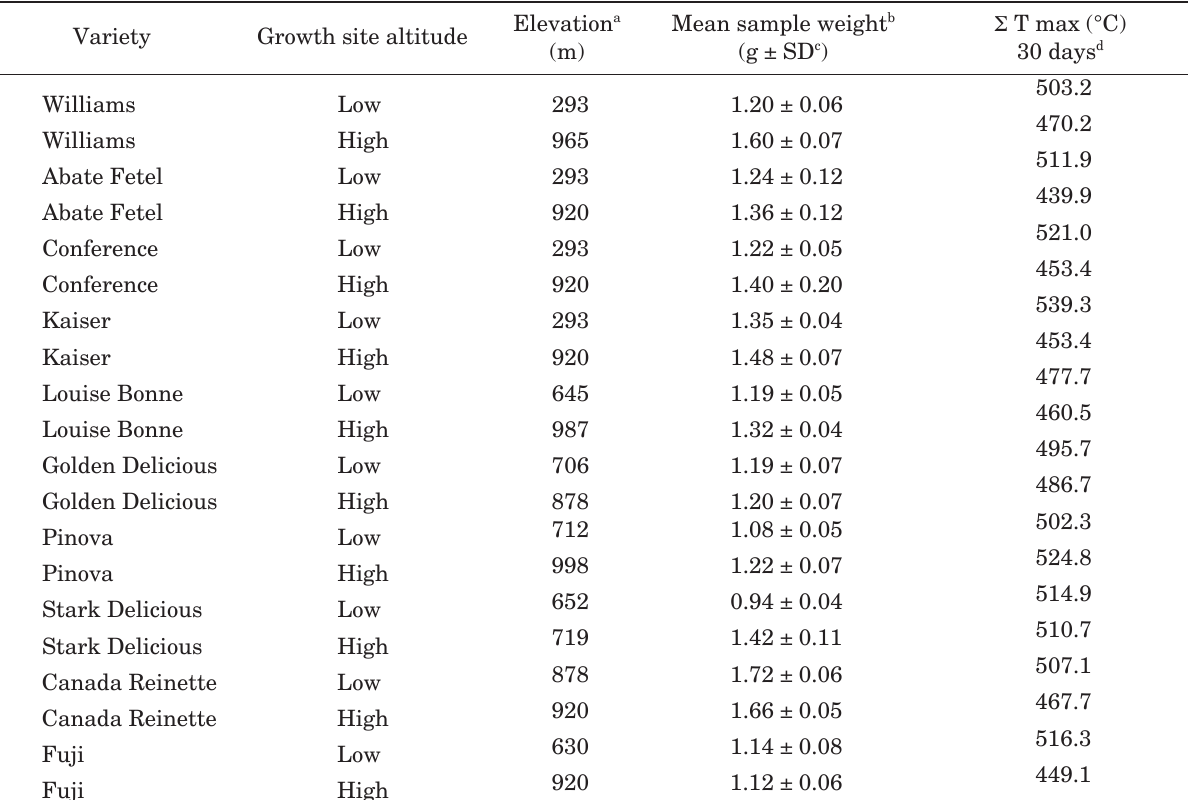
Table 1. Flower samples analysed as shown in Figure 2.